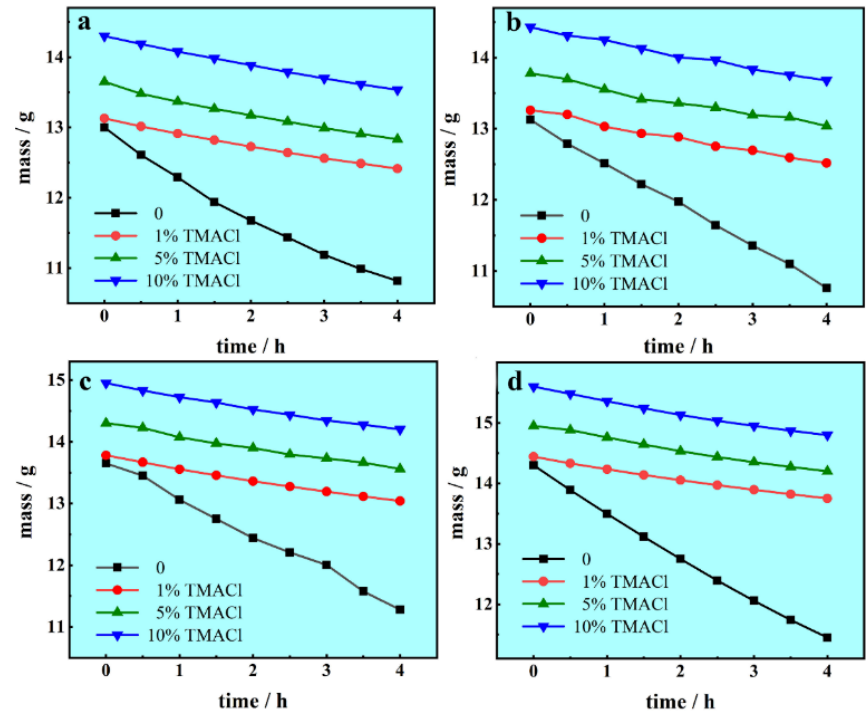
Figure 1. The mass-time transients of the electrolyte volatility experiments in the AlCl 3 -NaCl-KCl molten salts electrolyte, ( a ) no additive, ( b ) 1 wt.% NaI, ( c ) 5 wt.% NaI, ( d ) 10 wt.% NaI, at 150 °C.